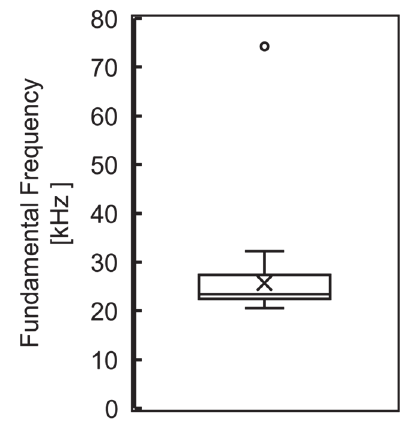
Figure 4. Distribution of fundamental frequencies ( n = 45): 20 kHz to 30 kHz, which is suitable for heating iron and stainless steel. A high frequency plot was recorded for heating aluminum pots; none of them deviated from the intermediate frequency range. Table 1. Measurements of magnetic field around household induction cooker.